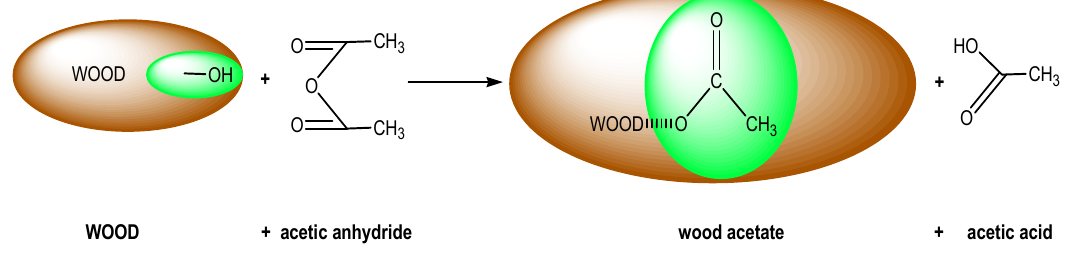
Figure 1. The reaction of wood with acetic anhydride [6]